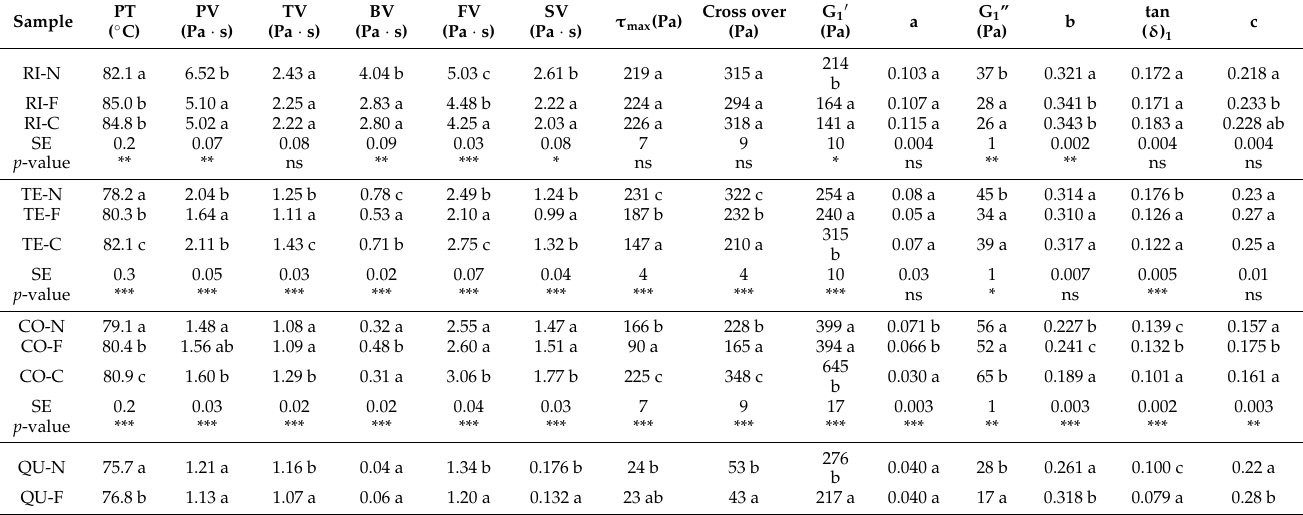
Table 6. Pasting properties of the studied flours and rheological properties of the gels made with